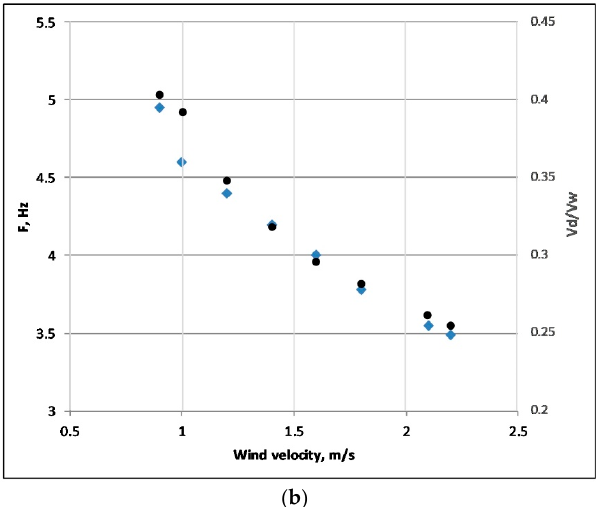
Figure 6. Spectra of wind waves ( a ). The frequency F of dominant wind waves (blue symbols) and wind wave age (black symbols) ( b ) as functions of wind velocity.